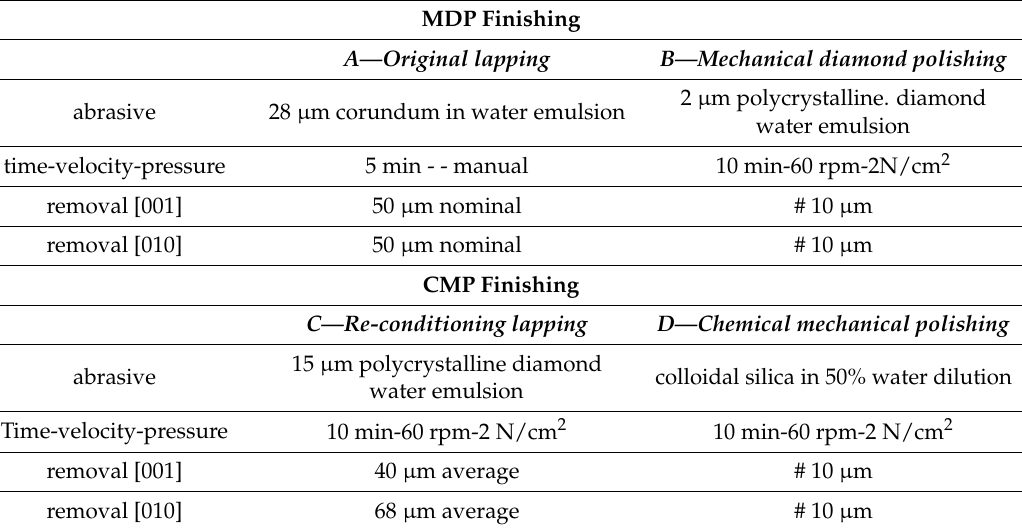
Table 1. The surface treatment parameters.